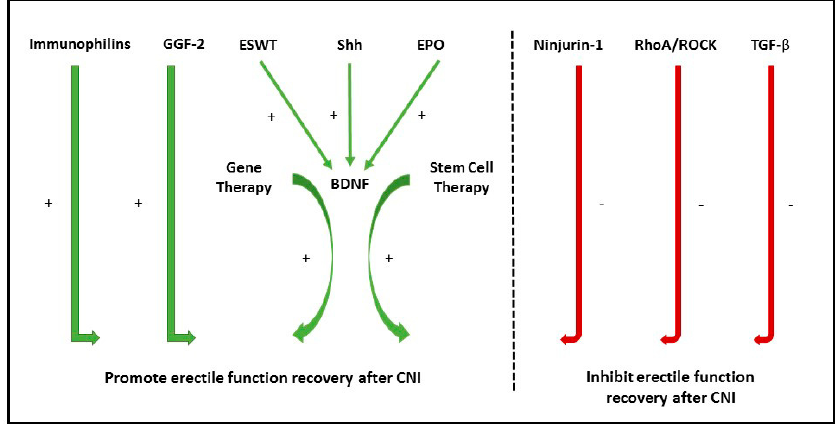
Figure 1. Summary of promoters and inhibitors of erectile function recovery after cavernous nerve injury (CNI). GGF-2: Glial Growth factor 2; ESWT: Extracorporeal Shock Wave Therapy; Shh: Sonic Hedgehog protein; EPO: Erythropoietin; BDNF: Brain-derived Neurotrophic Factor; Ninjurin-1: Nerve Injury-Induced Protein 1; ROCK: Rho-associated protein kinase; TGF- β : Transforming Growth Factor- β .